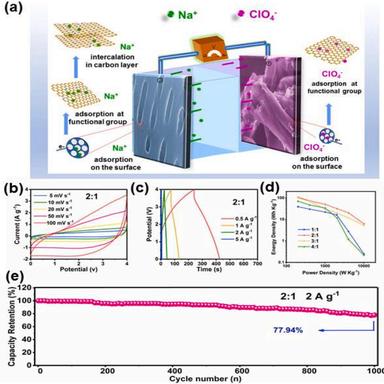
a) Schematic illustration of the energy-storage mechanisms for the NHC-5//NPC-60 SICs devices. b) CV curves in the range of 5–100 mV s − 1 . c) Galvanostatic charge–discharge profiles in the range of 0.5–5 A g− 1 . d) Ragon plots with different cathode-to-anode mass ratios. e) Cycling performance for SICs with anode-tocathode mass ratios of 2:2 tested at 2 A g− 1 between 0 and 4.0 V.